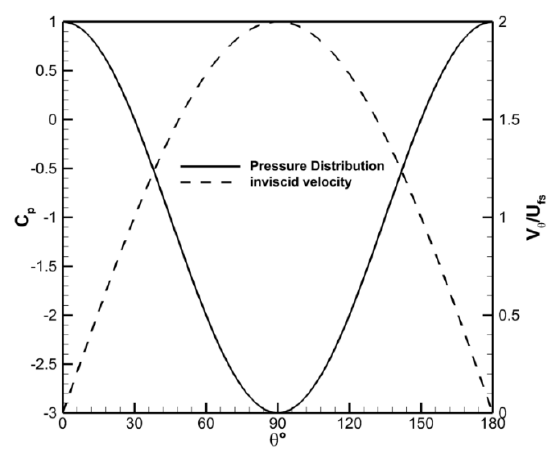
Figure 5. Surface velocity and pressure distribution for inviscid flow around a circular cylinder.